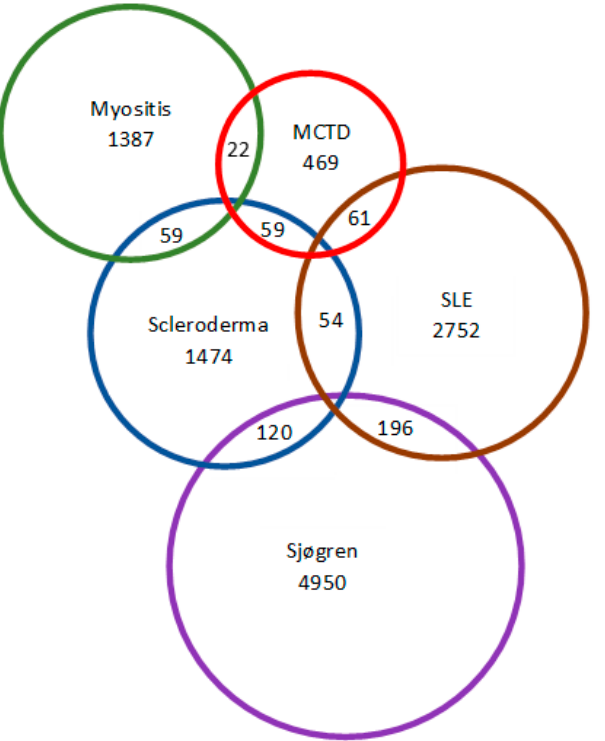
Figure 1. Diagram showing overlapping CTD diagnoses and number of patients with more than one CTD diagnosis during the study period. Table 2. CTD-ILD: Cumulative frequencies of ILD, PH, and ILD with PH among patients with CTD. All Table 1. CTD: Age and gender distribution within each CTD subgroup and frequencies of each CTD diagnosis over time. Variable